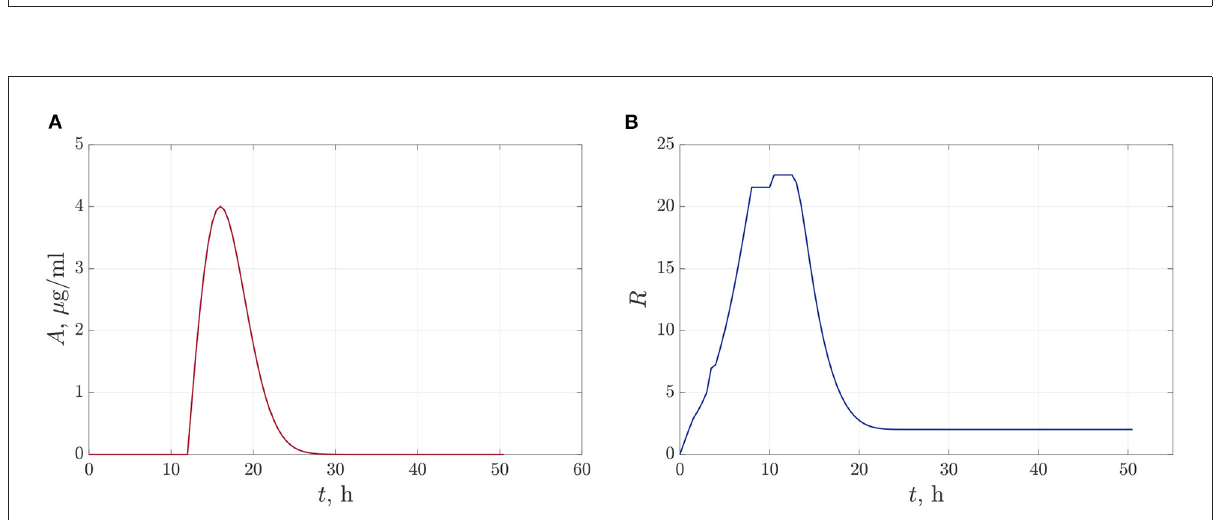
FIGURE5 The dynamics of changes in antibiotic concentration (A) , and the total linear size of bacterial colonies at single antibiotic treatment (B)